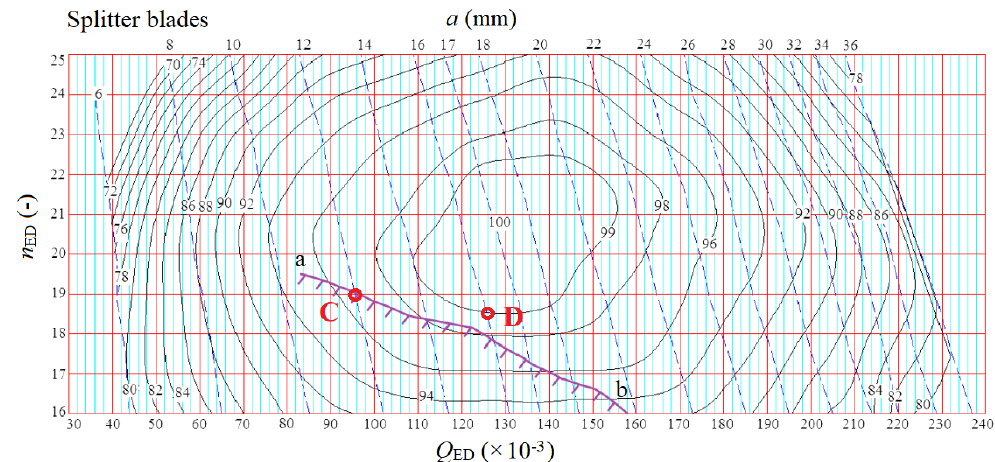
Figure 9. Hill diagram in parameters ( Q ED , discharge factor; n ED , speed factor) for the splitter blades.